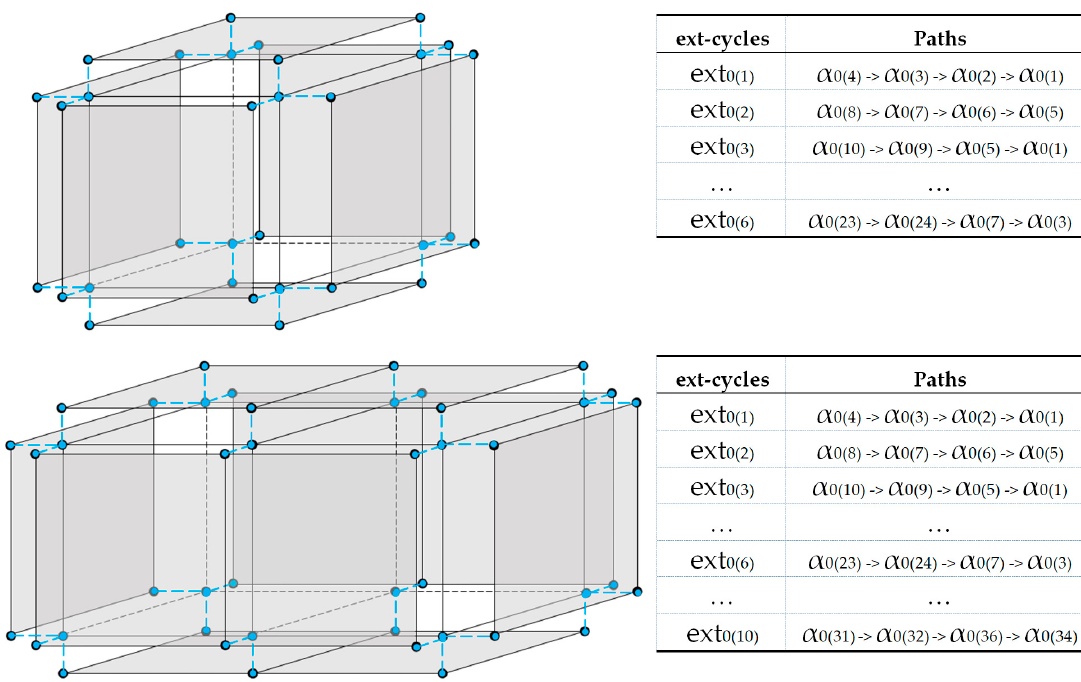
Figure 4. α 3 -cycles and their connectivity.